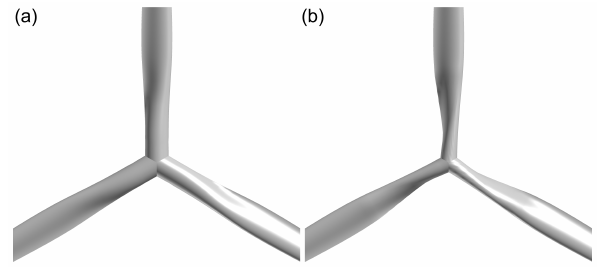
Figure 4. The IEA 10MW reference wind turbine baseline geome- try (a) and mesh modifications needed (b) , resulting in an improved flow solver